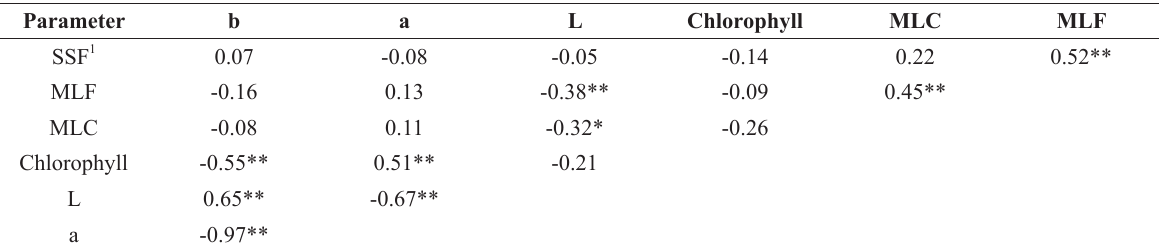
Phenotypic correlations among the variables used in evaluation of melon germplasm in regard to resistance to vegetable leafminer, Fortaleza, CE, Brazil,